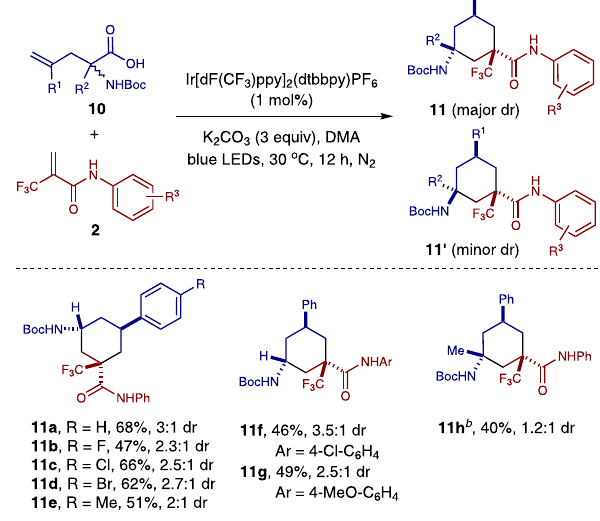
Fig. 8 Application to the syntheses of 1,3,5-trisubstituted cyclohexanes. a Reaction conditions: 1 mol% of Ir[dF(CF 3 )ppy] 2 (dtbbpy)PF 6 , 0.1 mmol of 2 , 0.15 mmol of 10 and 0.3 mmol of K 2 CO 3 in DMA (2.0 mL) for 12 h under blue LEDs irradiation at 30 °C. Combined isolated yields of both diastereomers are reported. The dr was determined by crude 1 H NMR analysis . b The reaction was performed with 2 mol% of Ir[dF(CF 3 ) ppy] 2 (dtbbpy)PF 6 , and 2.0 equiv of 10 h for 18